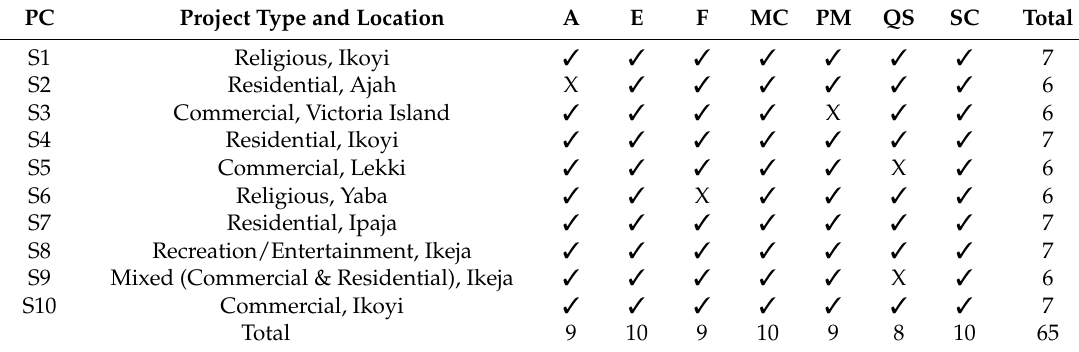
Table 1. Interviewees and projects’